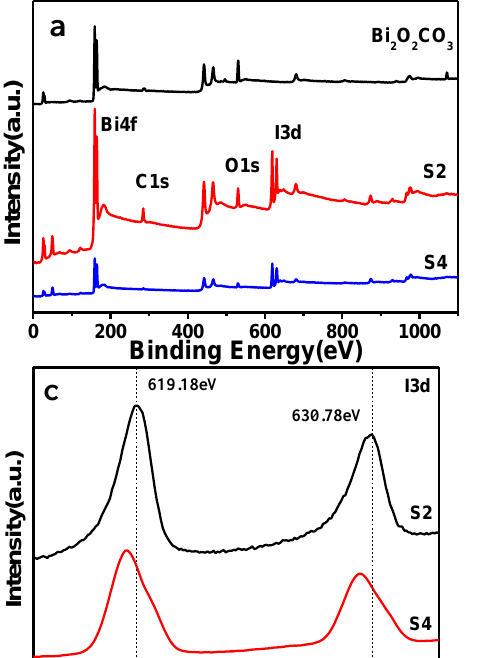
lower than in Bi 2 O 2 CO 3 . This result confirms Bi 2 O 2 CO 3 is consumed to form BiOI during the reaction.